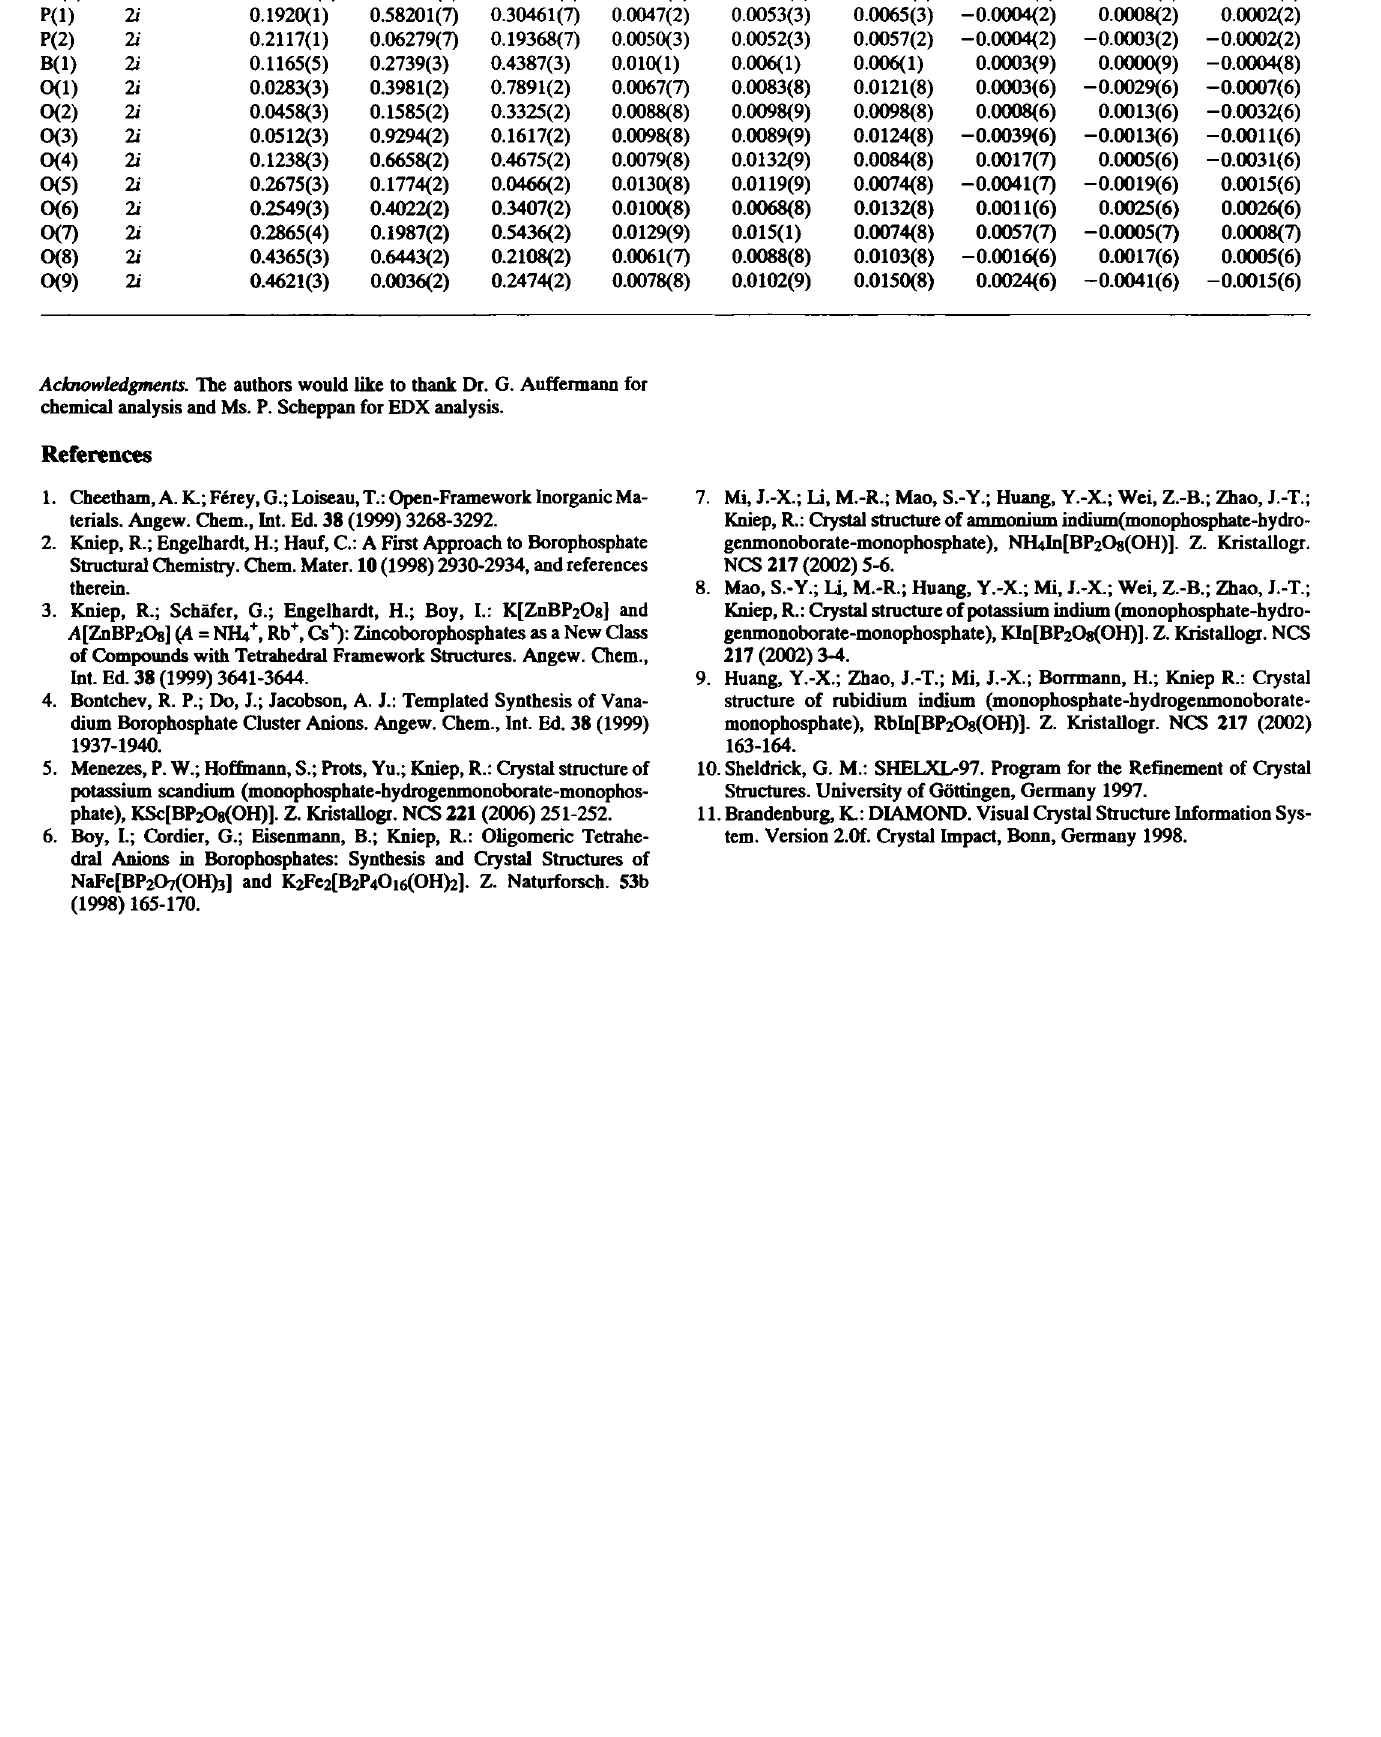
Table 3. Atomic coordinates and displacement parameters (in Ä 2